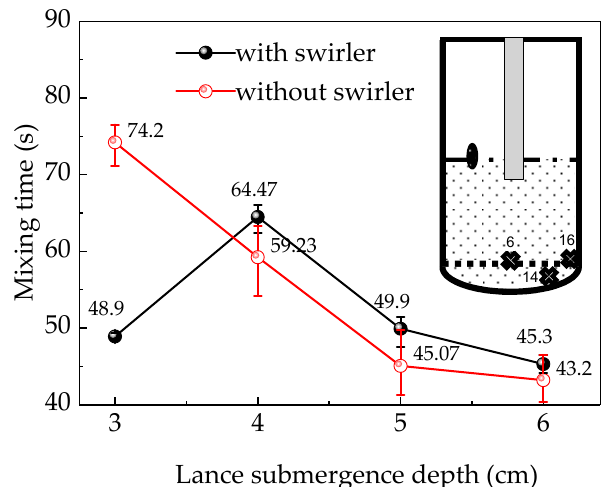
Figure 5. The relationship between mixing time and lance submergence depth.